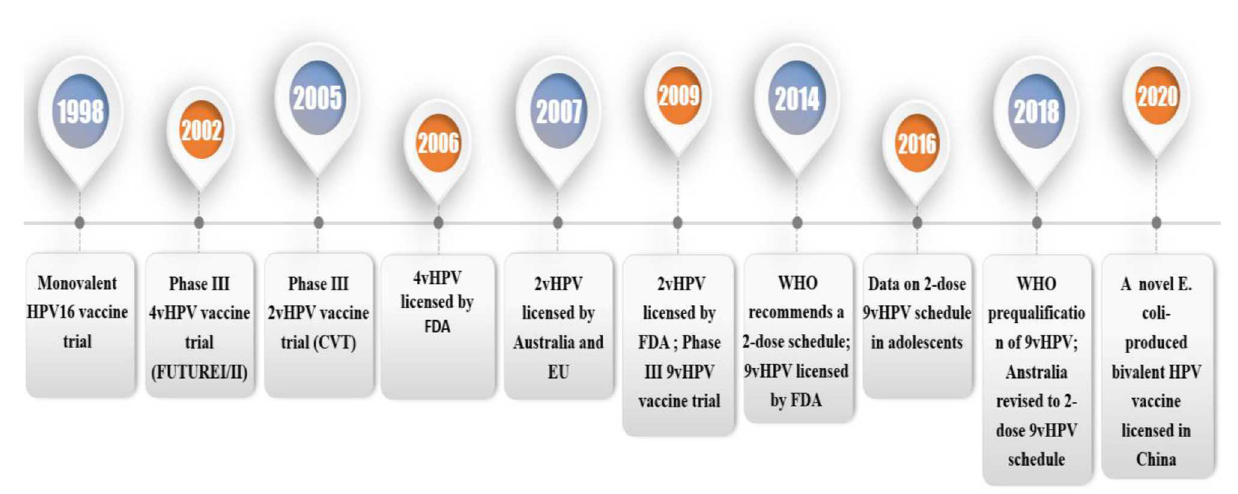
into two types: high-risk and low-risk types, among which the high-risk type can cause epithelial precancerous lesions and cancer (9). HPV16, 18, 31, 33, 35, 39, 45, 51, 52, 56, 58, 59, and 68 constitute 13 types of high-risk HPV. HPV 16 and HPV 18 have the highest carcinogenicity